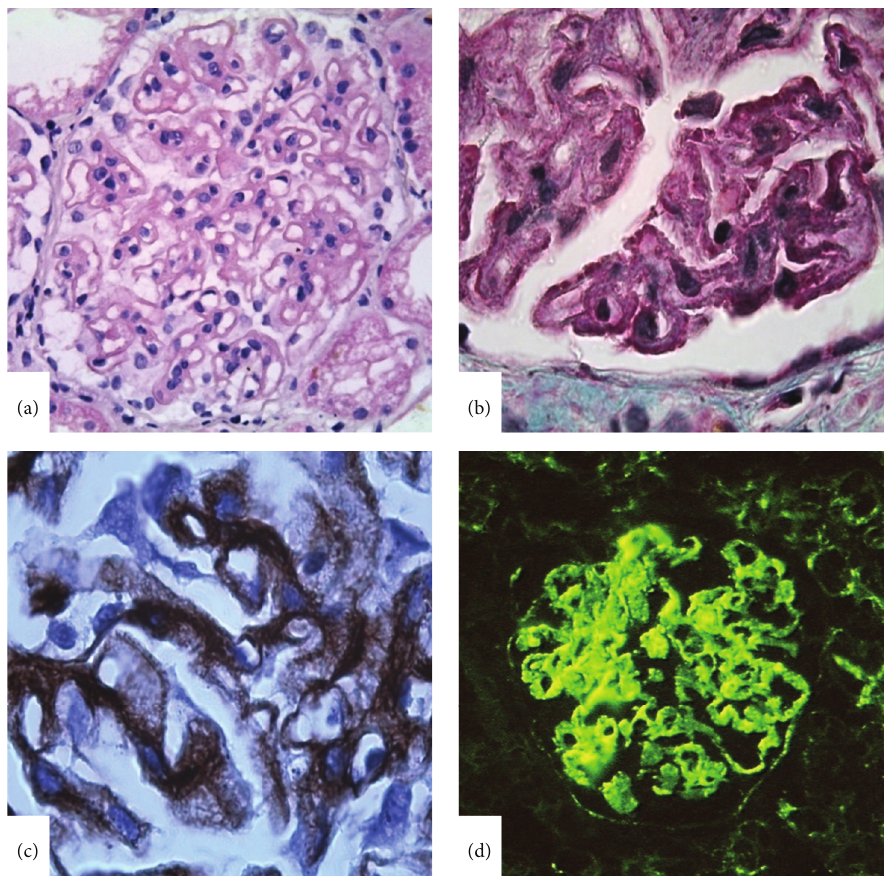
Figure 5: Lupus nephritis class V. (a) Significant glomerular capillary wall thickening in global distribution. (b) Subepithelial fuchsinophilic deposits revealed in Masson Trichrome stain. (c) “Spikes” in glomerular capillary wall indicator of membranous nephropathy by Periodic Schiff-Methenamine Silver Stain. (d) Continuous subepithelial IgG deposits in the glomerular capillary wall (IFM, ×